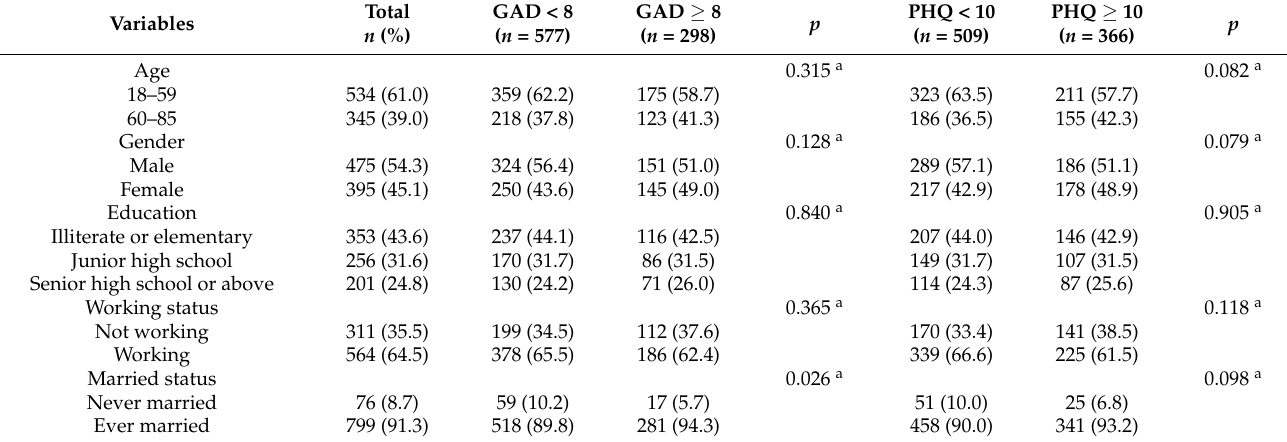
Table 1. Patients’ characteristics, anxiety and depression ( n =